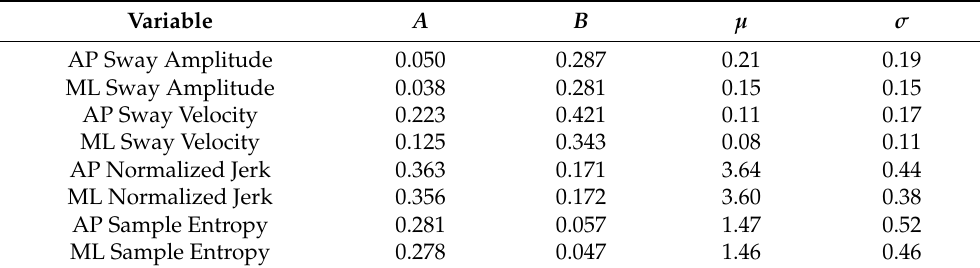
Table A1. Values of the parameters for the computation of sway complexity and sway intensity scores from the instrumented variables descriptive of instrumented modified Romberg test